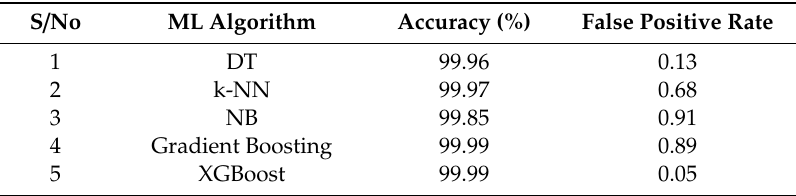
Table 6. Accuracy and false positive rate of binary classification.